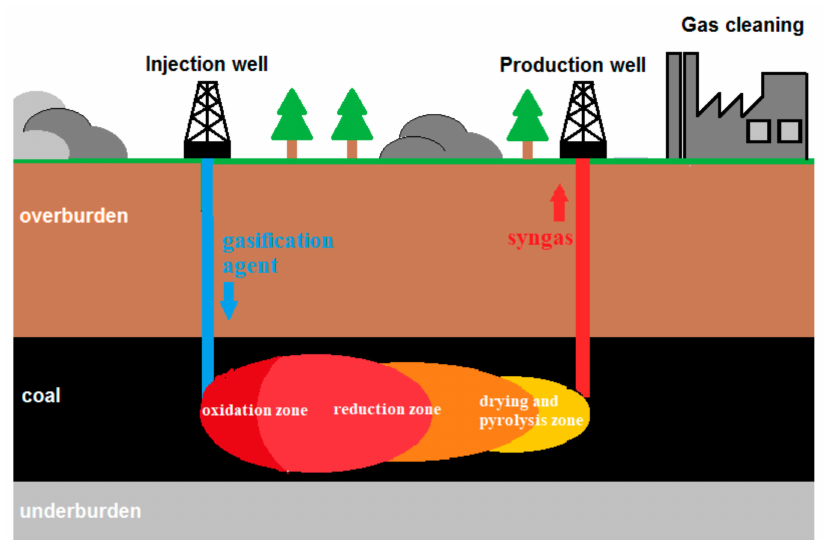
Figure 1. The scheme of the UCG process (Source: own